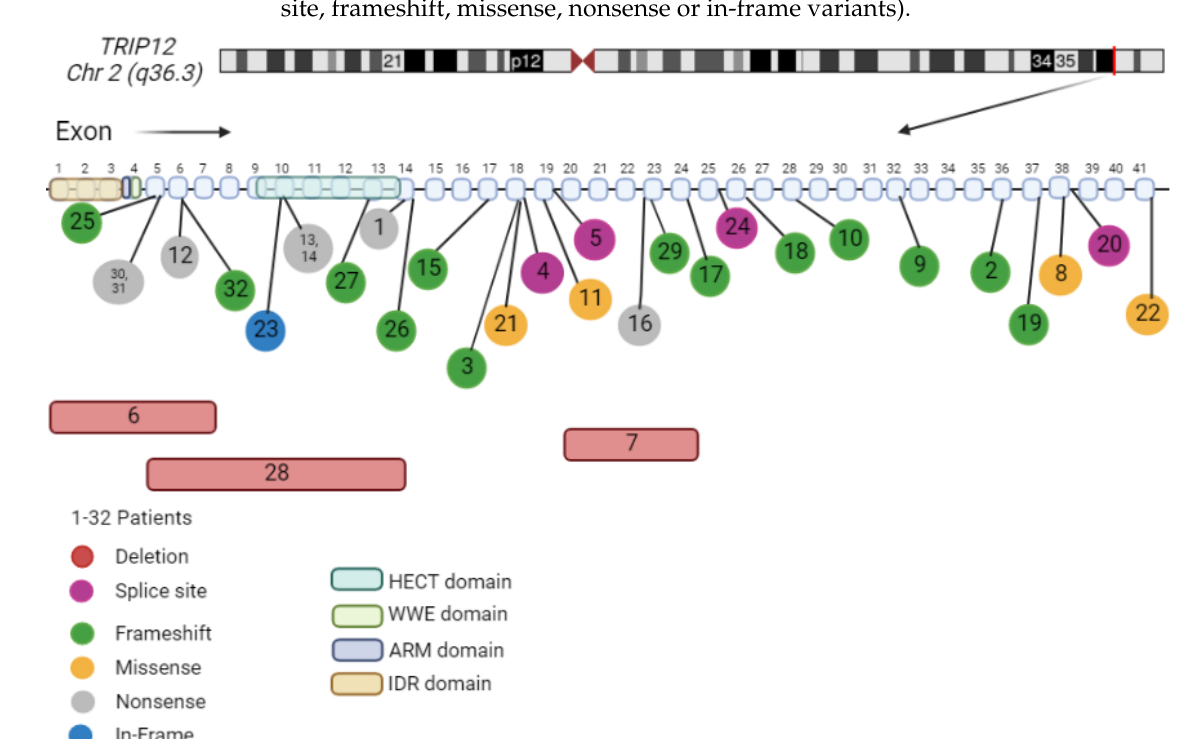
Figure 1. Individuals ’ genetic information. For corresponding variant information, see Table 1. Cases with deletions (red square), splice site (purple circle), frameshift (green round), missense (yellow circle) and nonsense (grew circle) variants. Alamut Visual version 1.6.1 NM_004238.3 TRIP12. Created with Biorender.com (accessed on 03-03-2022) [5,24].